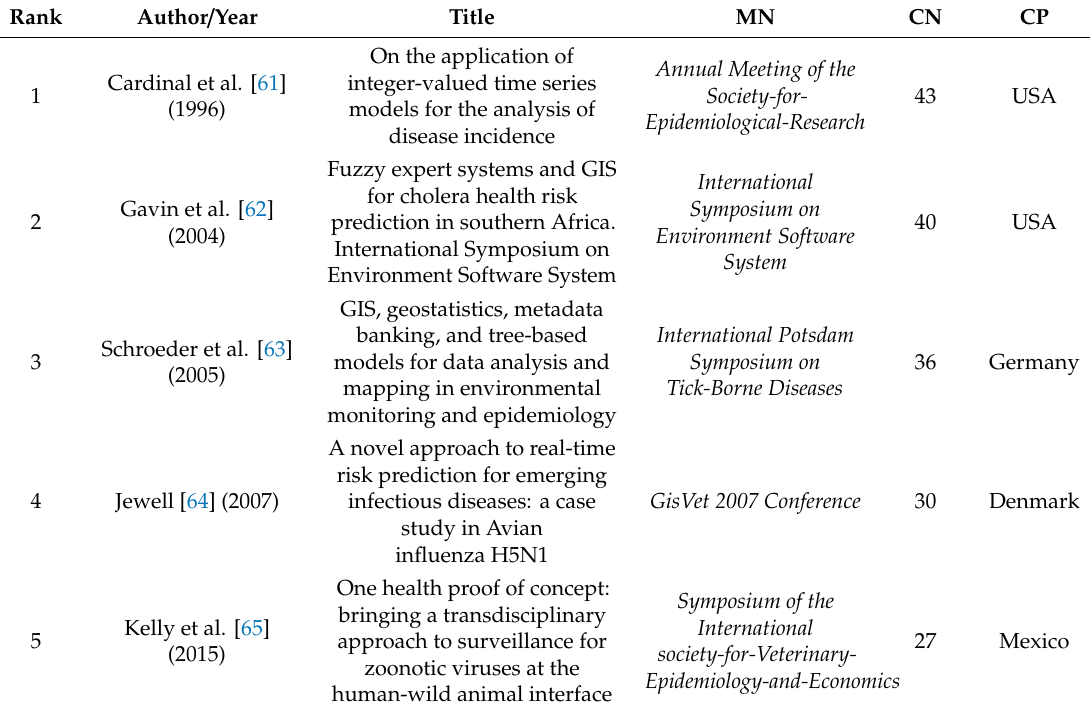
Table 6. The top 5 cited proceedings papers in the field of prediction of infectious